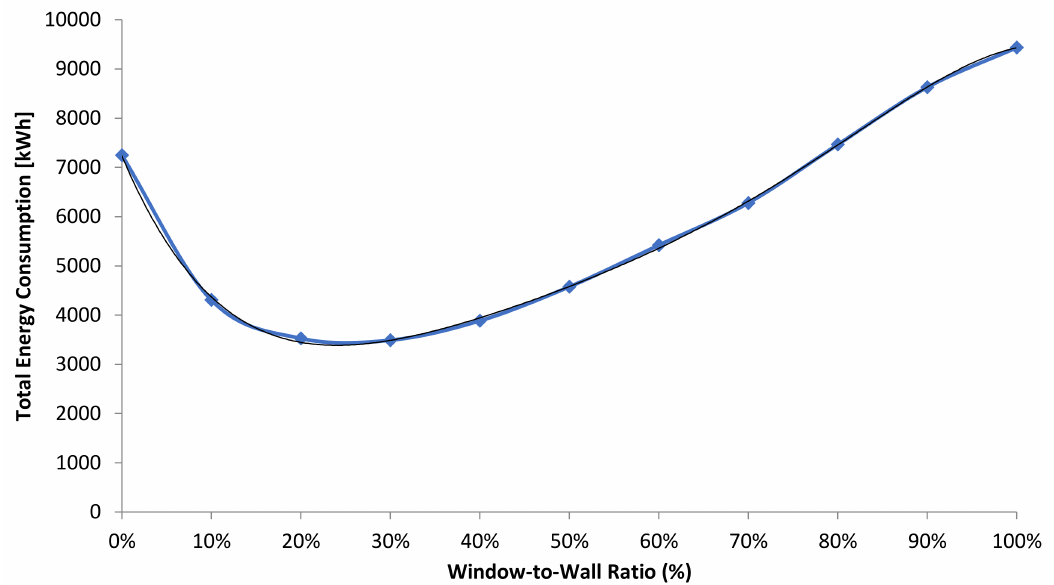
Figure 5. Total building energy consumption (kWh) for different WWR.